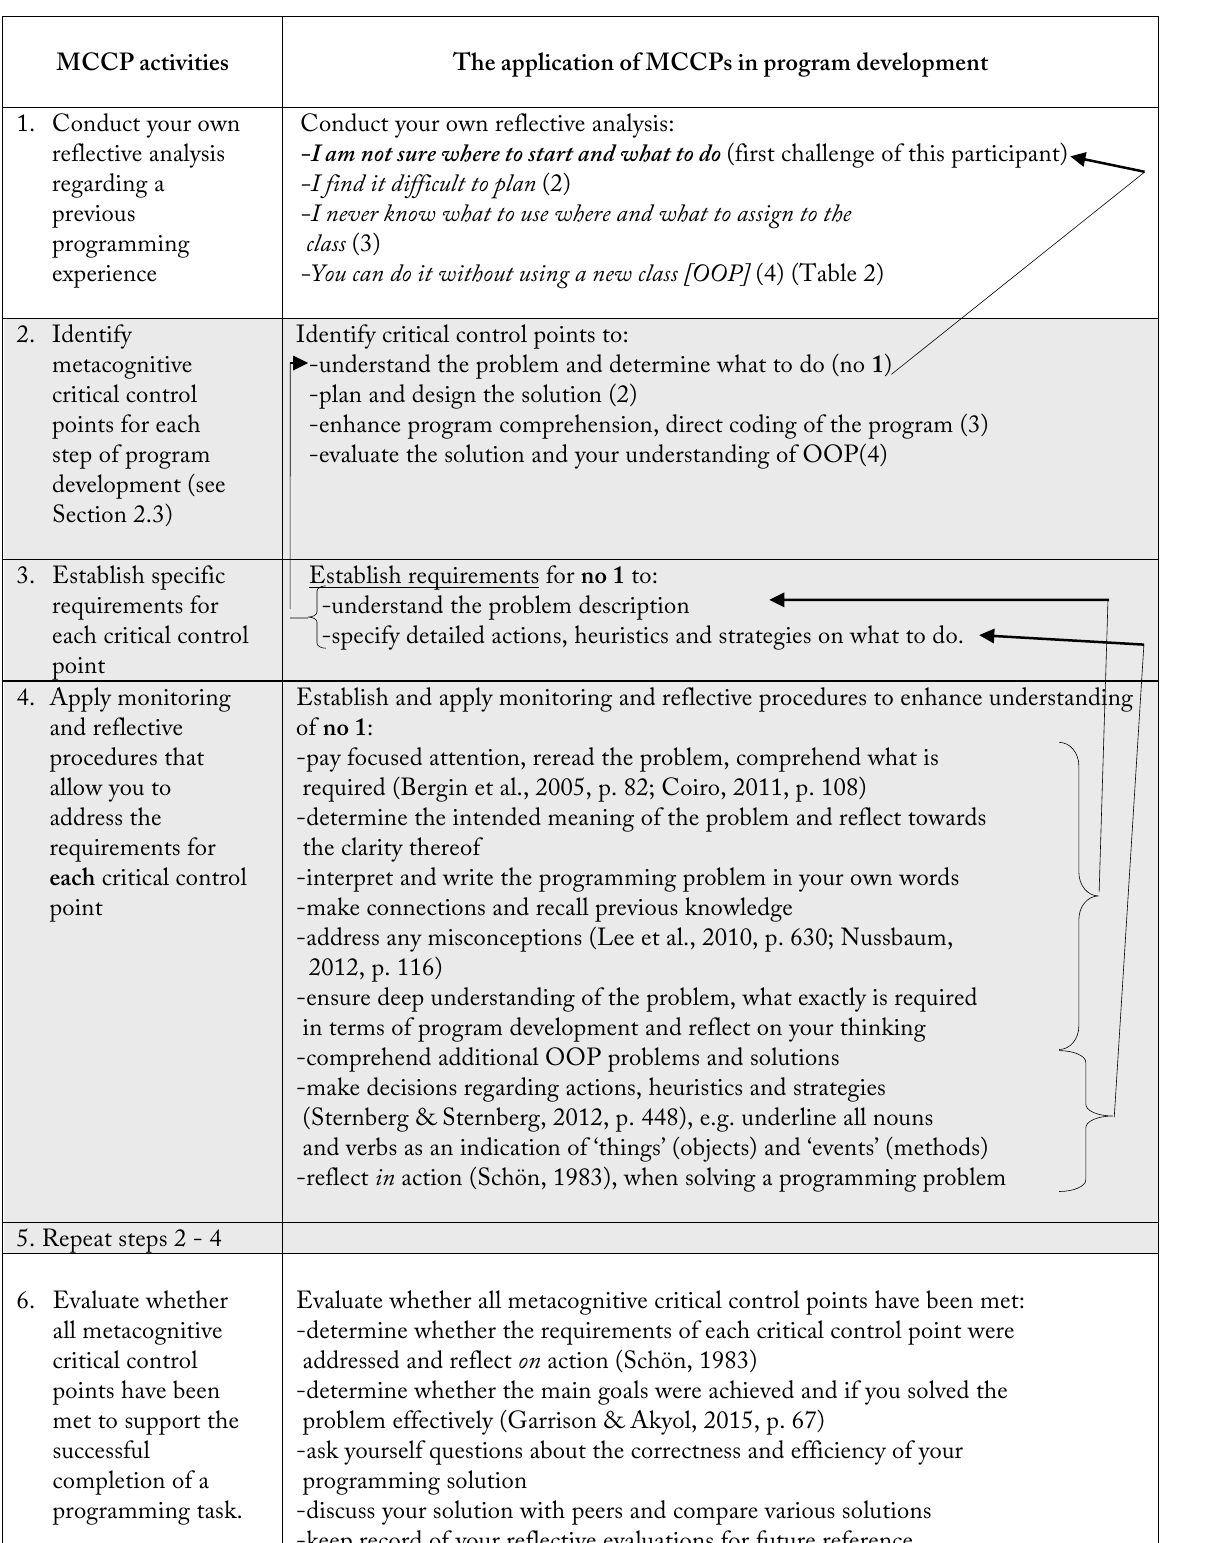
Table 6: An example of how to apply MCCPs in supporting P1